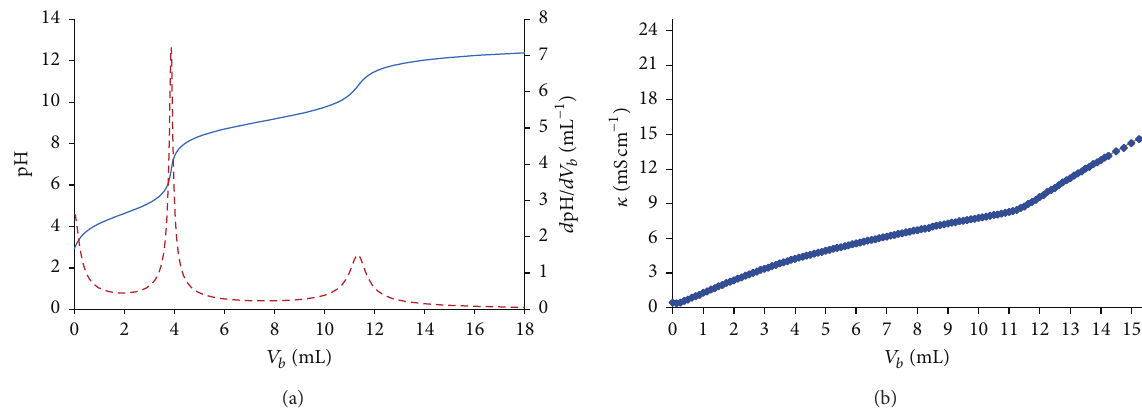
Figure 4: Plots obtained during titration of 20.00 mL of CH 3 COOH aqueous solution at a 0.053 molL −1 concentration and H 3 BO 3 at a 0.1025 mol L −1 concentration, with NaOH aqueous solution at 0.2743 mol L −1 concentration. (a) Calculated pH-metric plots: the solid line represents the plot pH = 𝑓(𝑉 𝑏 ) obtained with (17) while the segmented line represents the plot of 𝑑 pH /𝑑𝑉 𝑏 = 𝑓 󸀠 (𝑉 𝑏 ) ≈ Δ pH /Δ𝑉 𝑏 . (b) Conductometric plot 𝜅 = 𝑔(𝑉 𝑏 ) . The markers represent the experimental points obtained and the solid line represents the estimated plot with